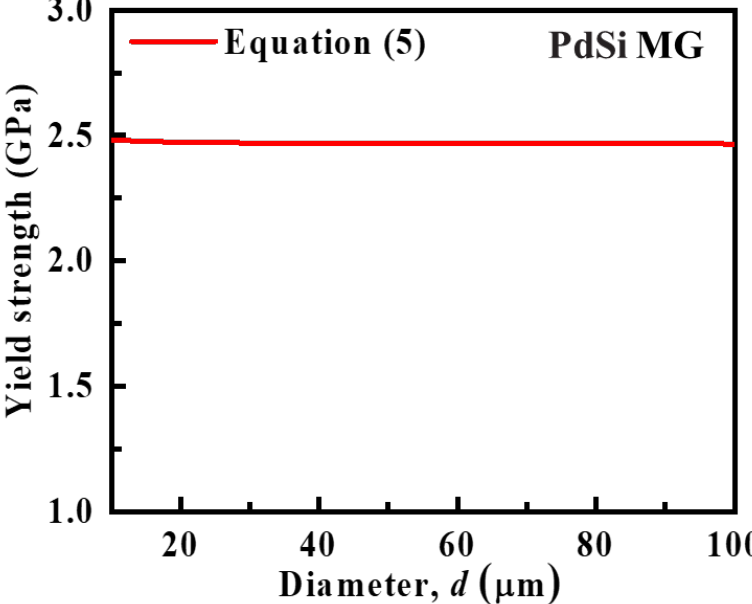
Figure 2. Yield strength as a function of sample size for submillimeter-sized MGs.